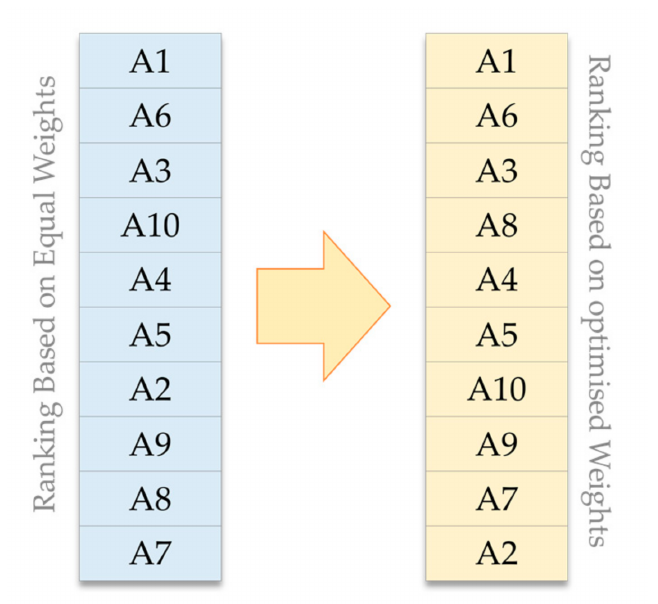
Figure 7. Comparison of results of alternatives